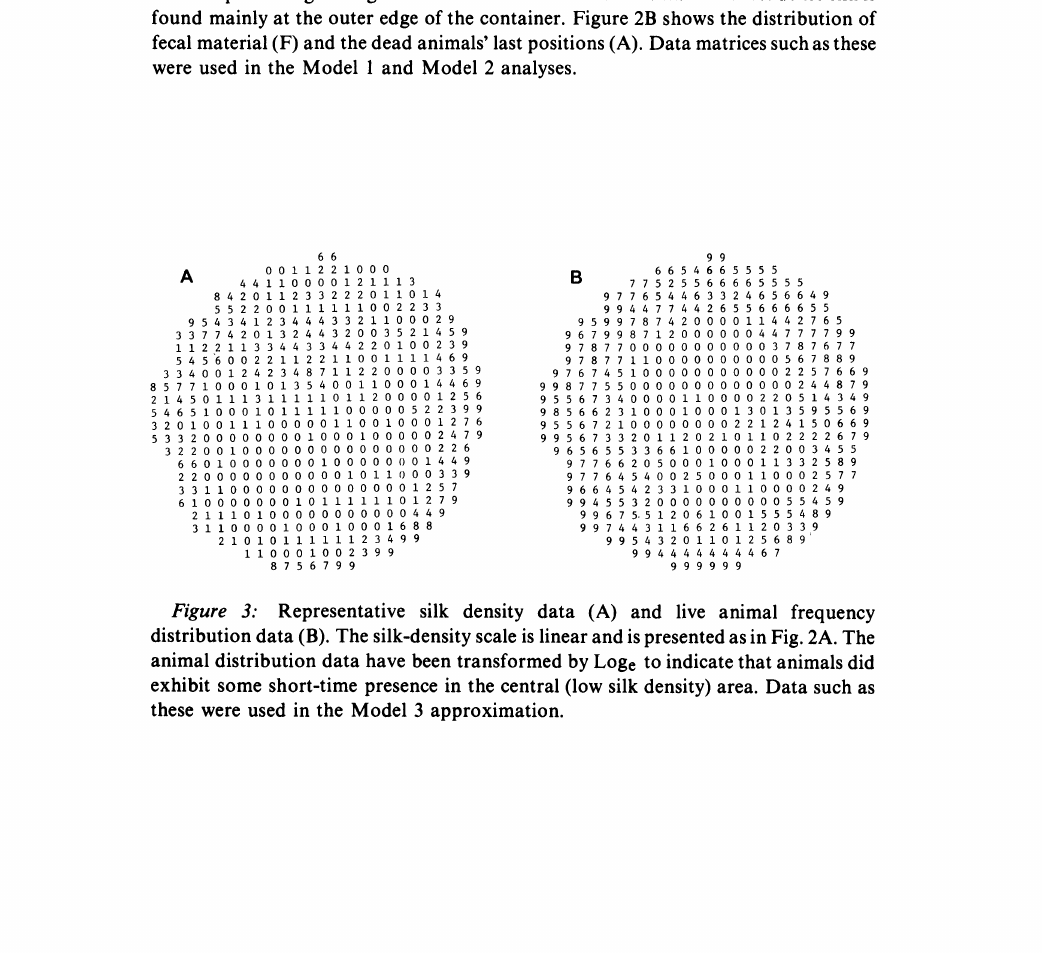
Figure 2: Representative silk-density image (A) and distribution data for animal and excreta positions (F). Silk-density data have been adjusted to a ten-level ordinal scale with 9 representing the highest observed silk densities. Note that the most dense silk is found mainly at the outer edge of the container. Figure 2B shows the distribution of fecal material (F) and the dead animals’ last positions (A). Data matrices such as these were used in the Model and Model 2 analyses.